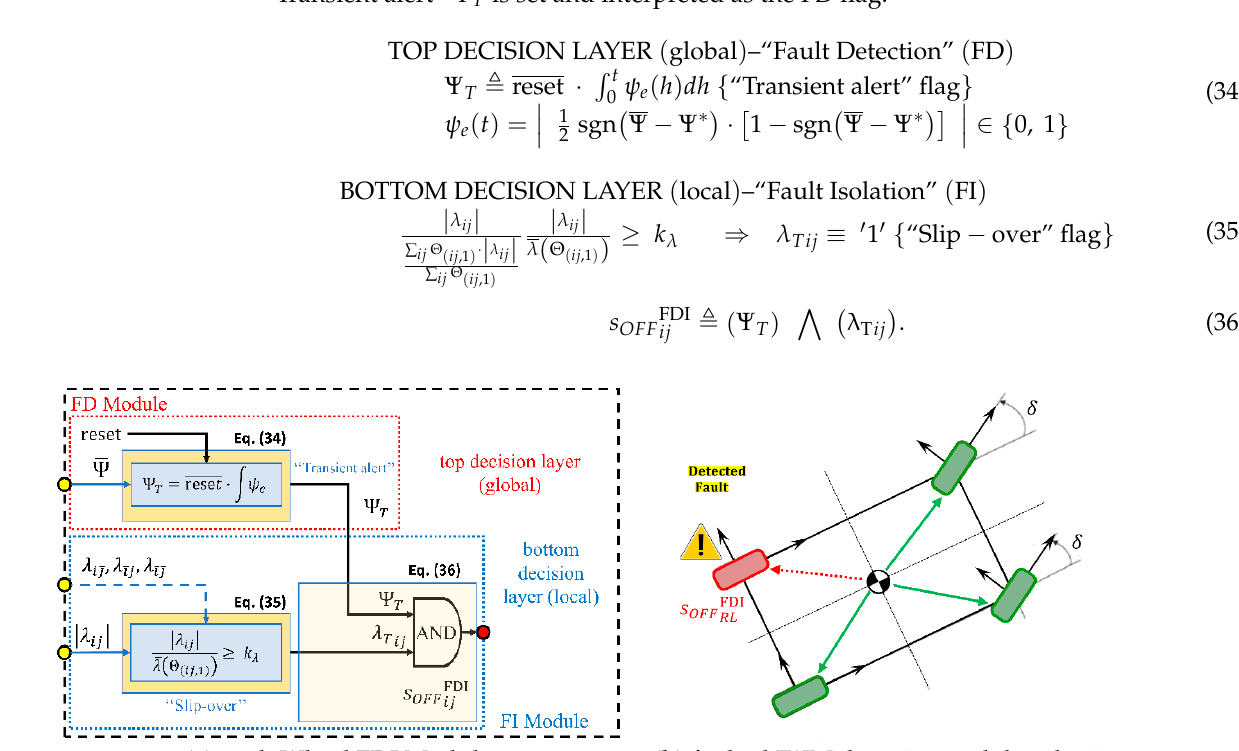
Figure 8. FDI: In-Wheel Motor switching-off.